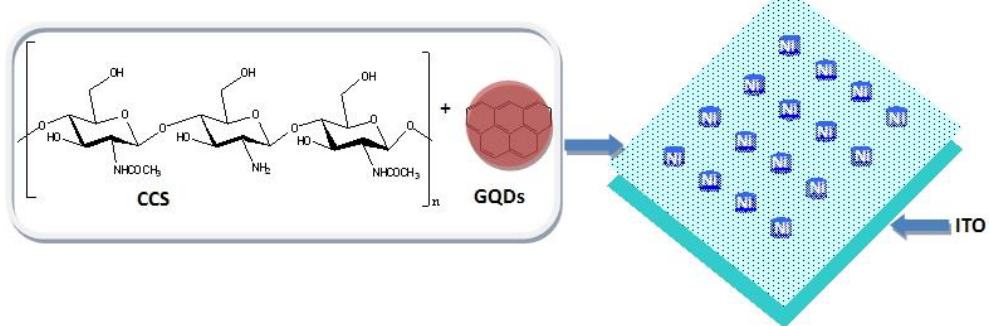
Figure 1. Schematic structure of carboxylated chitosan (CCS) and graphene quantum dots